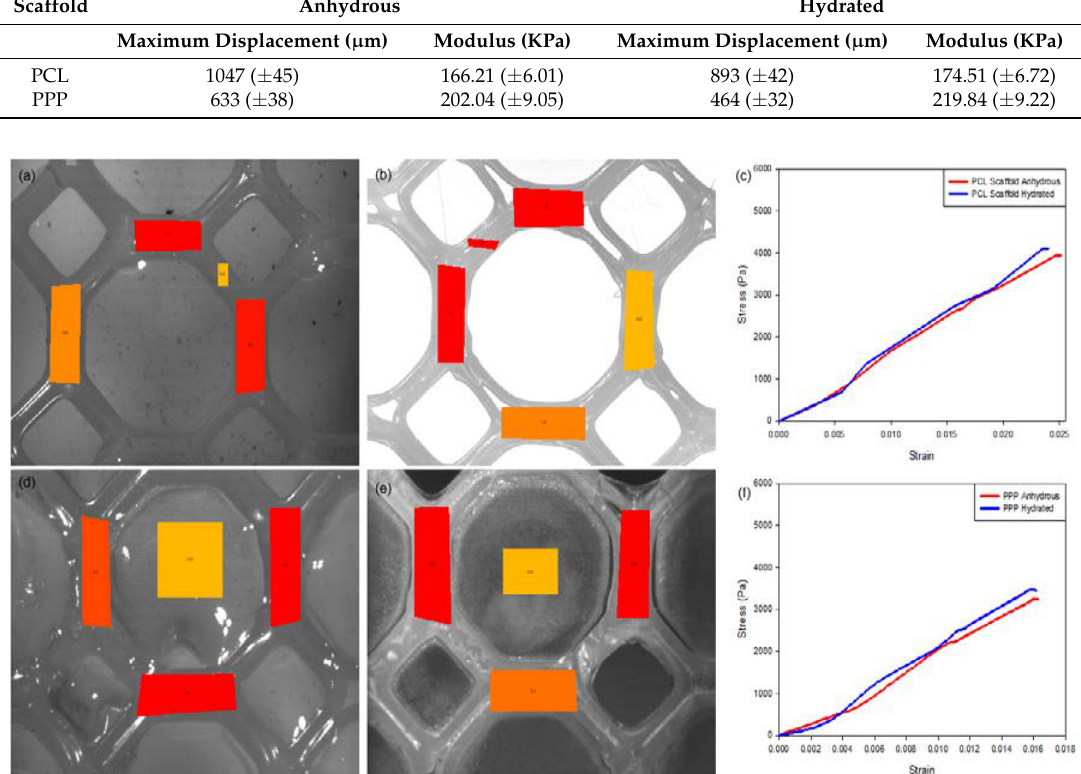
Table 1. Results of the mechanical strain assessment of the PCL and PPP scaffolds.